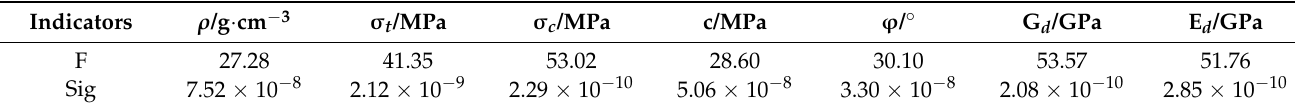
Table 5. Significance analysis table of the regression